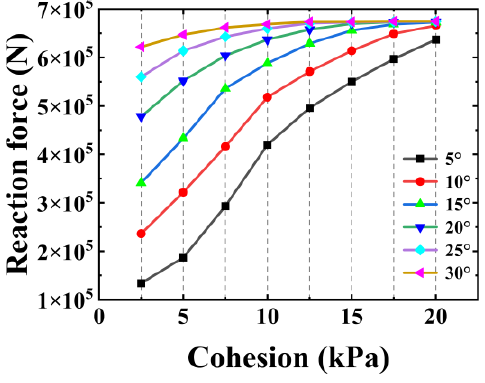
Figure 15. Friction angle – reaction force curve.